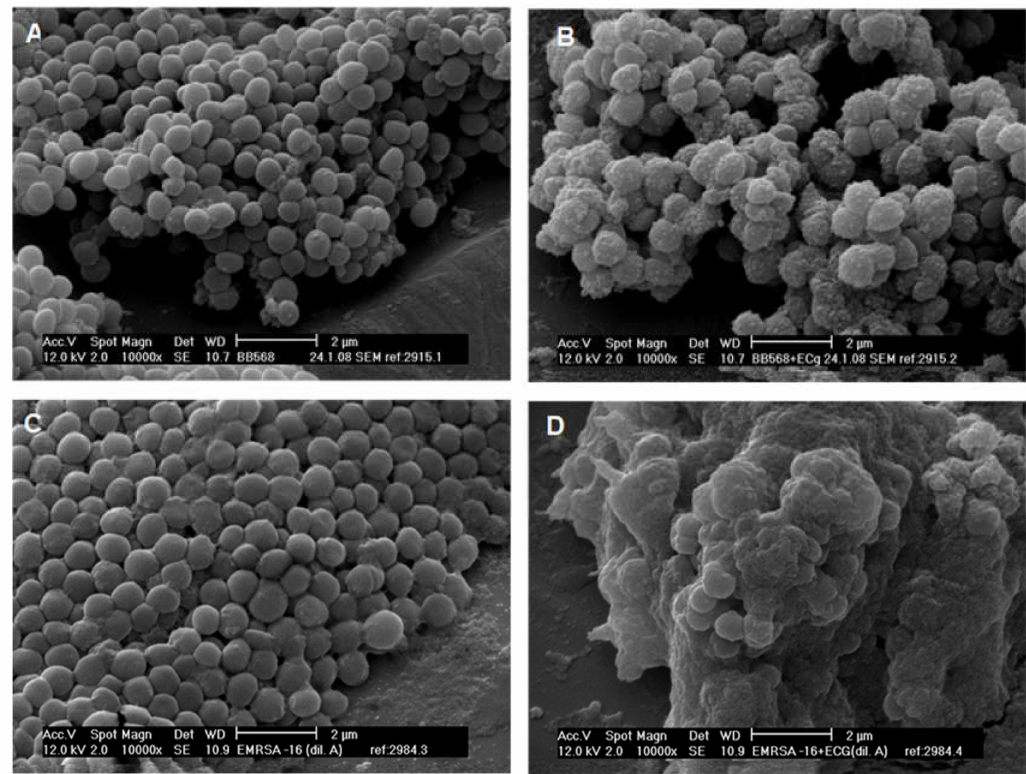
Figure 2. Scanning electron micrographs of S. aureus BB568 cells grown in non-supplemented Müller–Hinton broth (MHB; A ), in MHB containing 12.5 mg / L ECg ( B ). BB568 cells were incubated with cationised ferritin after growth in non-supplemented ( C ) and ECg-supplemented ( D ) MHB. Reproduced from [7] with permission from RightsLink / Elsevier.